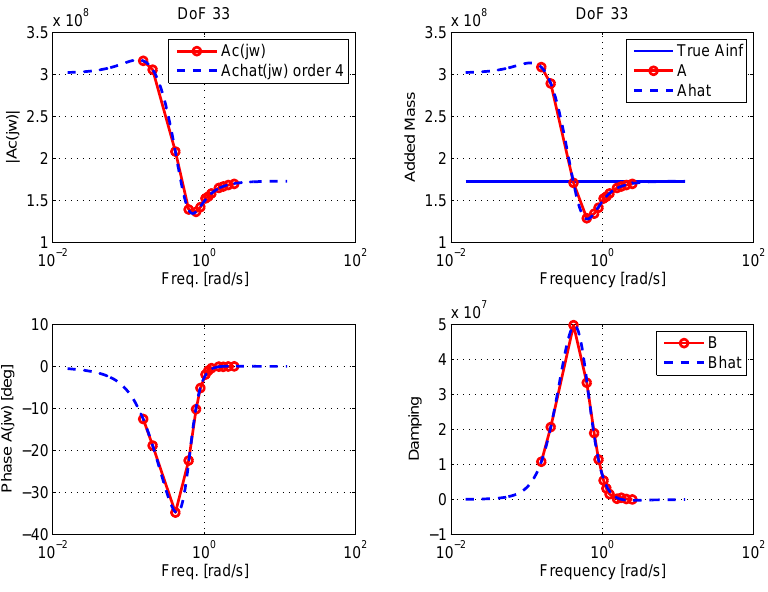
Figure 2: Fitting results for the FPSO. Left column: Frequency response ˜ A 33 ( jω ) and estimate. Right column: Reconstruction of added mass and damping from the identified fluid memory function ˆ K 33 ( jω ) based on an 2nd order